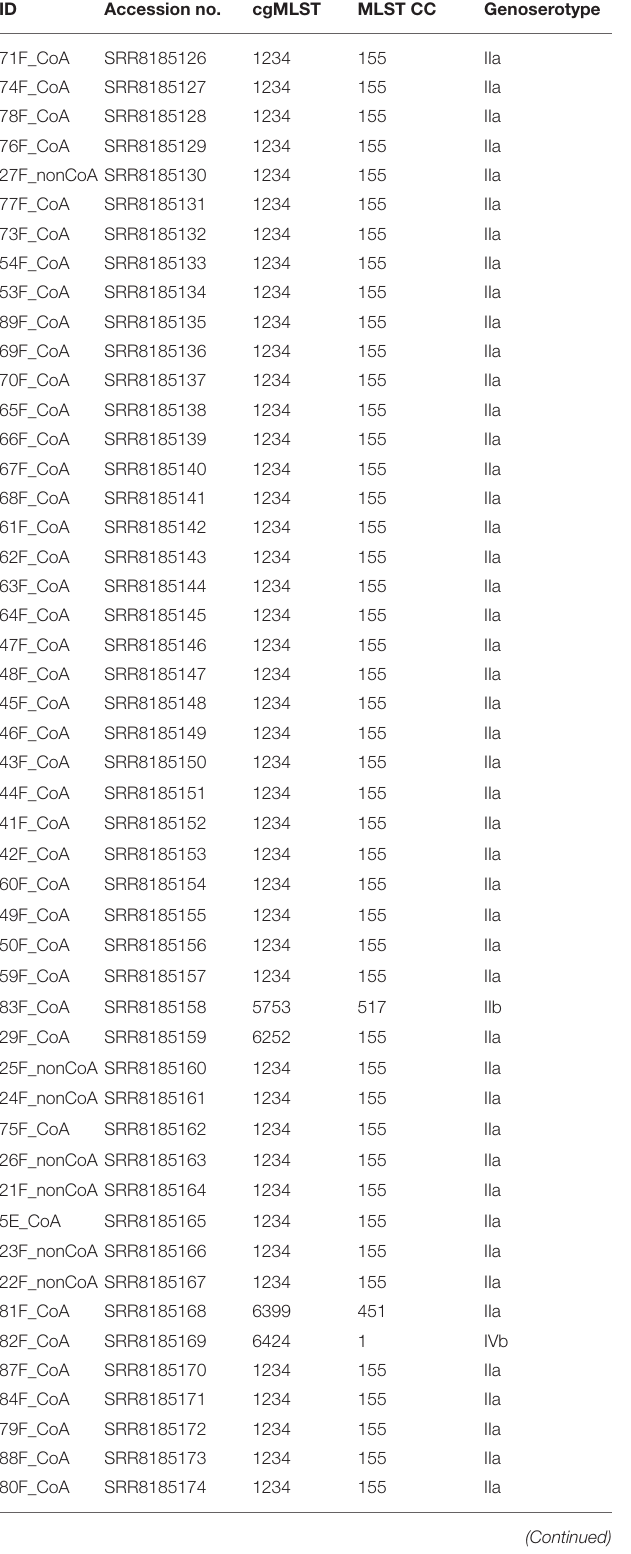
( Figure 3 : food isolates 81F, 82F, 83F, and 90F). After August 2018, the public health authorities found no further